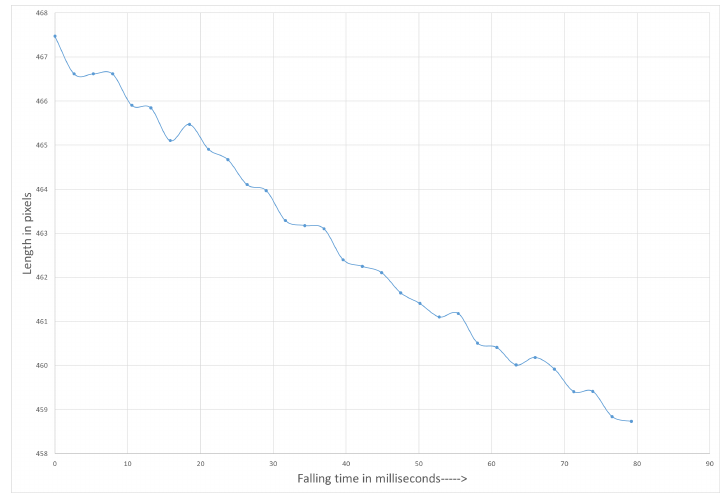
Figure 10. Measured length of free falling glass gob.